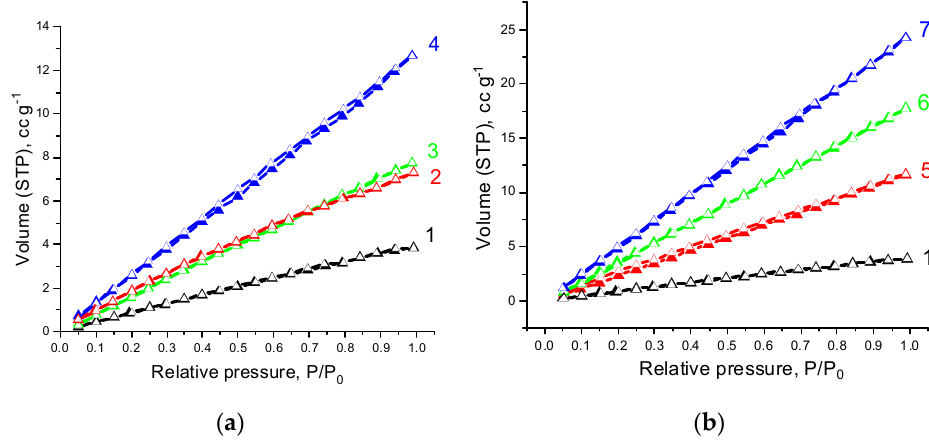
Figure 6. Low-temperature nitrogen adsorption (filled symbols) and desorption (open symbols) isotherms on the samples: 1—PHBV/PCL(1:2), 2—PHBV/PCL(1:2)/CNC(PVP)–5, 3—PHBV/PCL(1:2)/CNC(PVP)–10, 7—PHBV/PCL(1:2)/CNC(PAM)–15 ( b ).